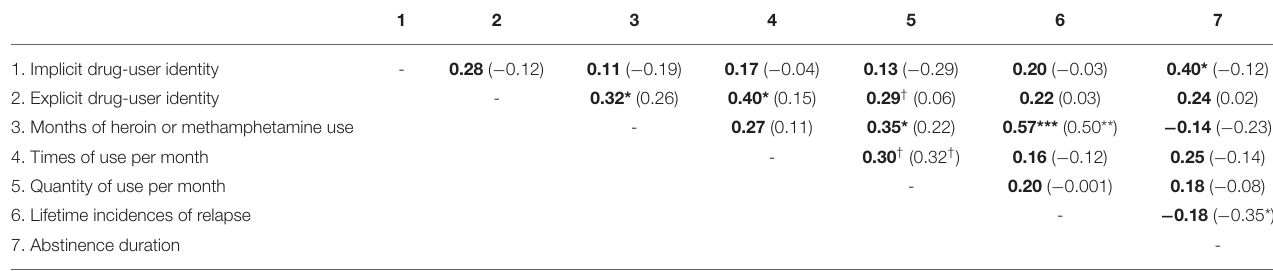
TABLE 2 | Pearson’s correlations for implicit and explicit self-identity as a drug user and drug-use behaviors and abstinence duration. 1